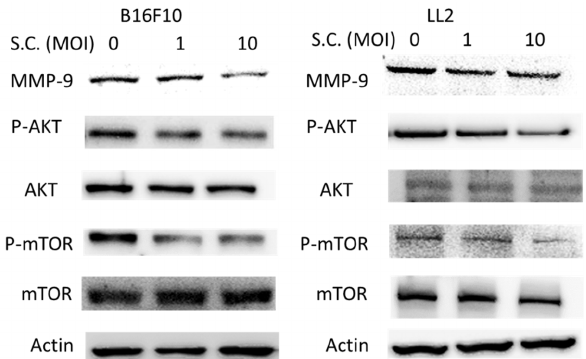
Figure 2. Effects of Salmonella (S.C.) on Matrix MetalloProteinase 9 (MMP-9) expression in B16F10 and LL2 cells. B16F10 cells and LL2 cells (2 × 10 5 cells/well) were placed into plates and incubated at 37 °C for 24 h. The cells cocultured with Salmonella (MOI = 1–10) for 4 h. The protein expression of B16F10 and LL2 cells was measured. Int. J. Mol. Sci. 2018 , 19 , x FOR PEER REVIEW